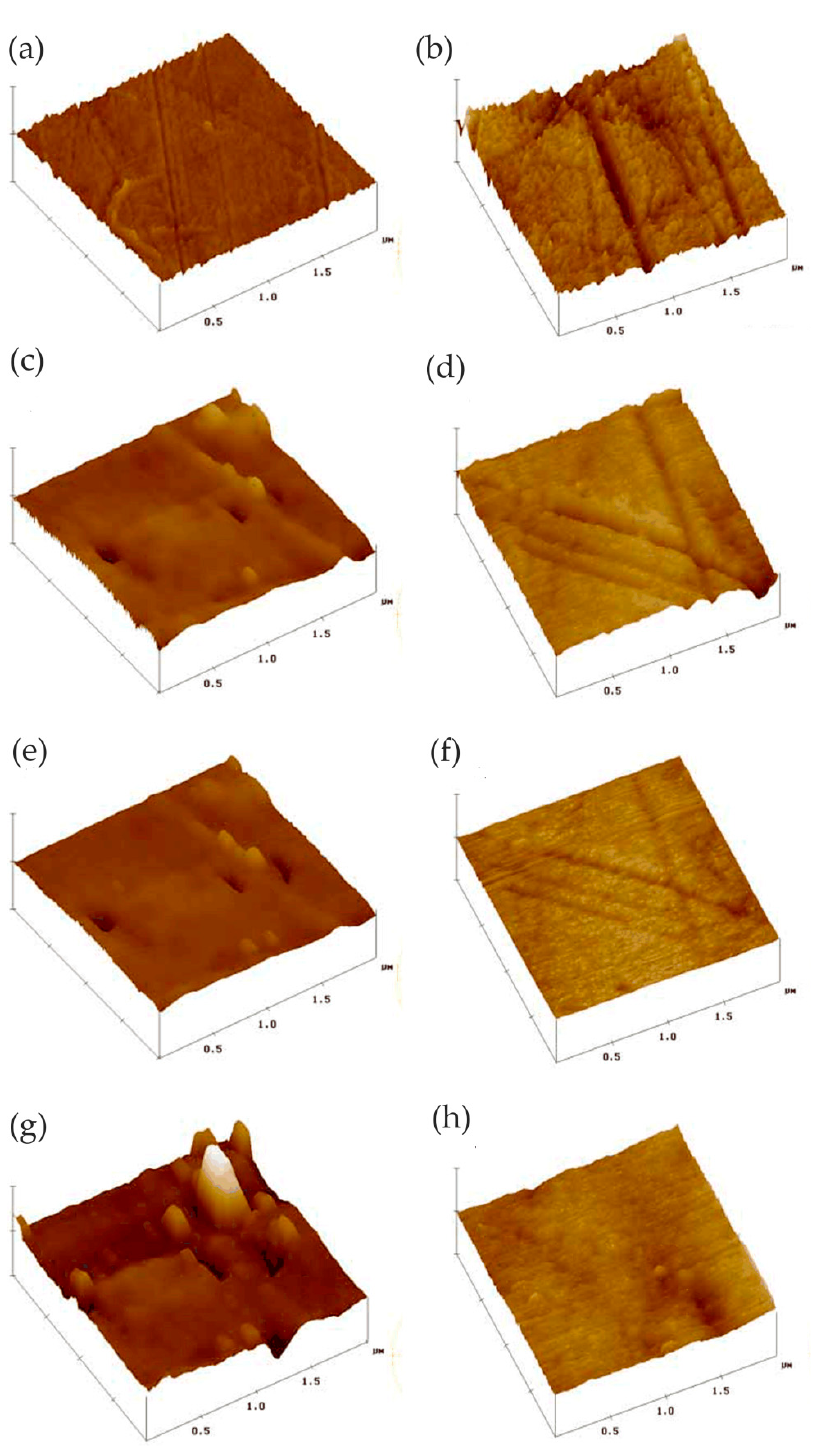
Figure 36. Morphological changes of copper in solution of 0.1 M NaCl ( a – d ) and 0.1 M NaCl + p -chlorobenzohydroxamic acid ( p -Cl-BHA) ( e – h ), at different times: ( a , e ) 0 min; ( b , f ) 15 min; ( c , g ) 30 min; ( d , h ) 45 min. Reprinted with permission from Reference [79]; copyright 1998 Springer. Cruickshank et al. [80] studied the anodic dissolution of polycrystalline copper in acid medium with or without corrosion inhibitor using EC-AFM. In 0.5 M H 2 SO 4 , the preferential corrosion of some grain surfaces occurred and then dissolved along grain boundaries. The addition of benzotriazole (BTA) formed a protective film that effectively inhibited the dissolution of copper. When the anode potential reached 200 mV, the protective film was stable. However, when the potential was as high as 300 mV, the film underwent local breakdown. In addition, Li et al. [81]